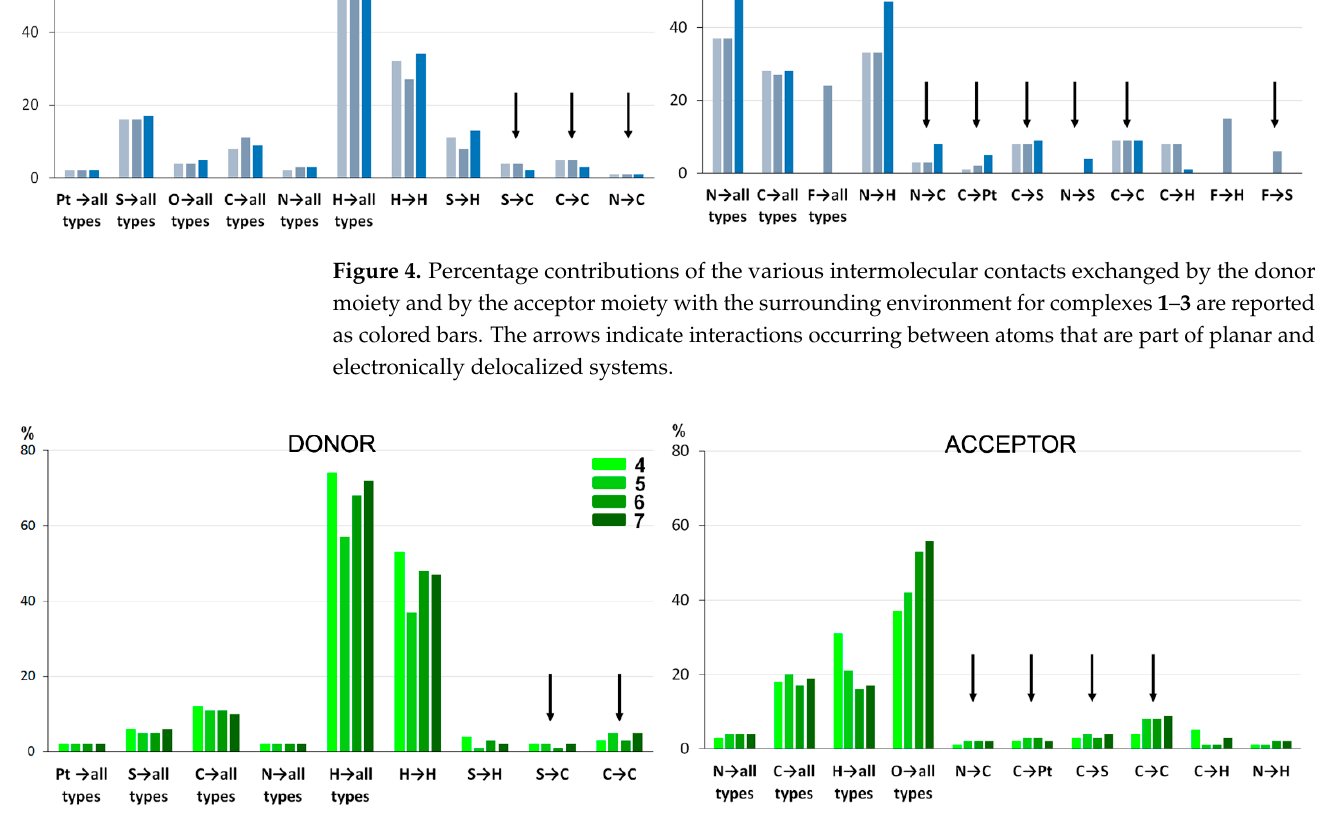
Figure 5. Percentage contributions of the various intermolecular contacts exchanged by the donor moiety and by the acceptor moiety with the surrounding environment for complexes 4 – 7 are reported as colored bars. The arrows indicate interactions occurring between atoms that are part of planar and electronically delocalized systems.